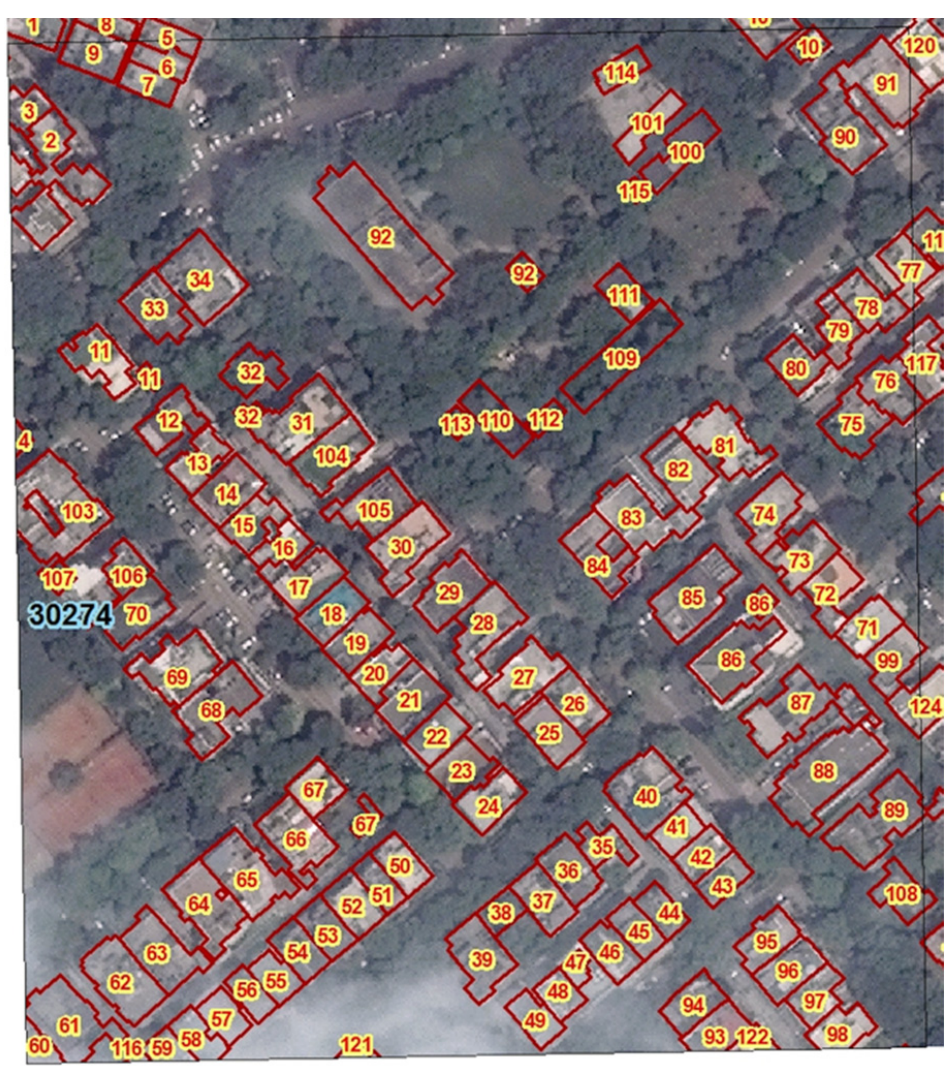
Figure 5. Reference number (RN) for each building in the Hauz Khas ward.